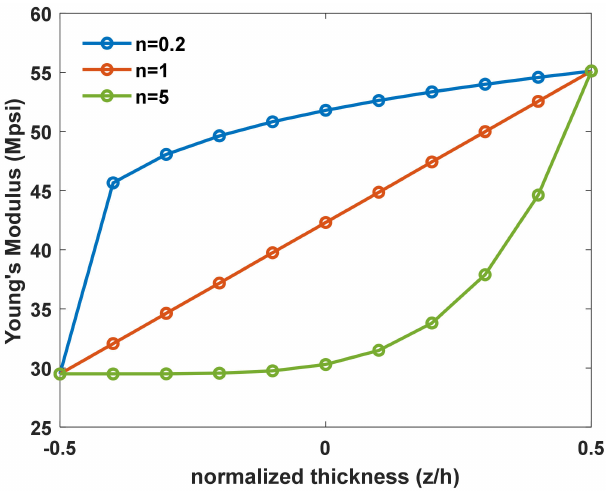
Figure 2. Variation of the Young’s moduli with the FGM plate